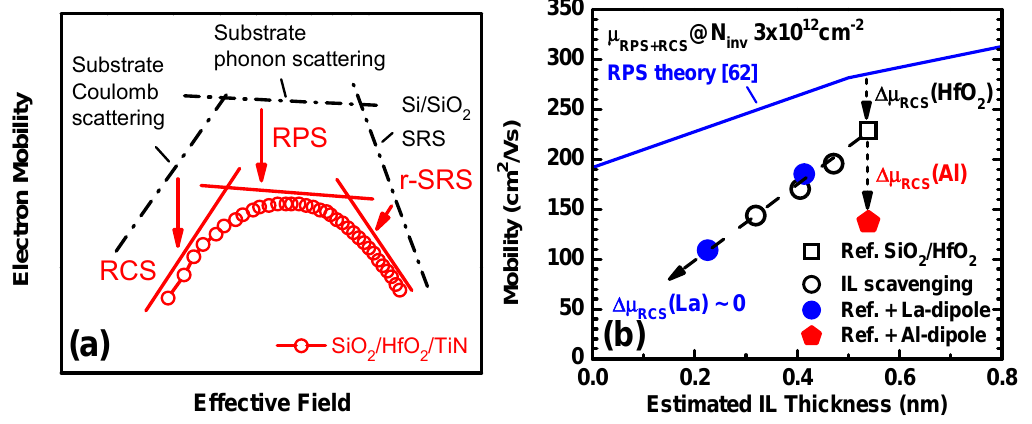
Figure 10. ( a ) Impacts of SiO red curve is obtained from a typical SiO ( b ) Electron mobility limited by RPS and RCS ( μ estimated IL thickness at N scavenging and La-(Al-) induced dipoles are included. The simulated dependence from the RPS theory [62] with ion impurity correction is also